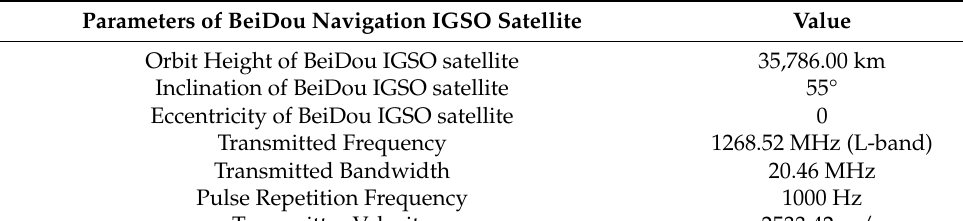
Table 5. Main experiment parameters of BeiDou IGSO satellite.